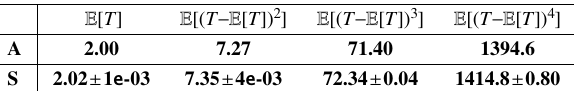
Table 4: Class 2 response time moments from TCP dataset 2.